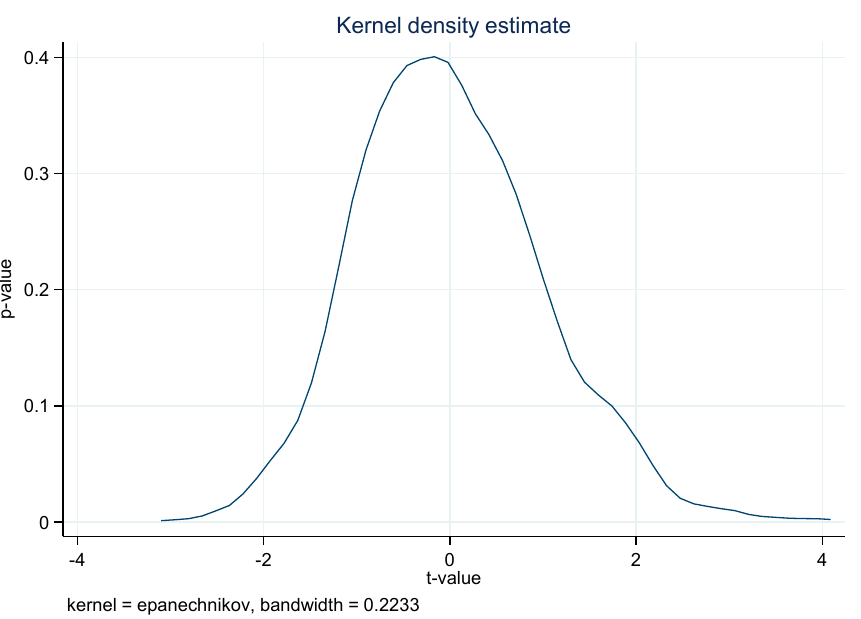
Figure 3. The graph of the policy estimation coefficient of 1000 random sampling experiment panels with a bandwidth of 0.2233 (fixed model).